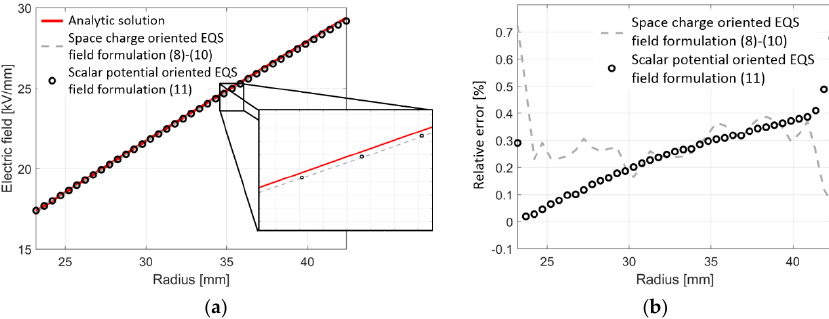
Figure 21. ( a ) Stationary electric field, computed with (8) – (11), together with the analytic solution; ( b ) relative error between both formulations and the analytic solution [59].